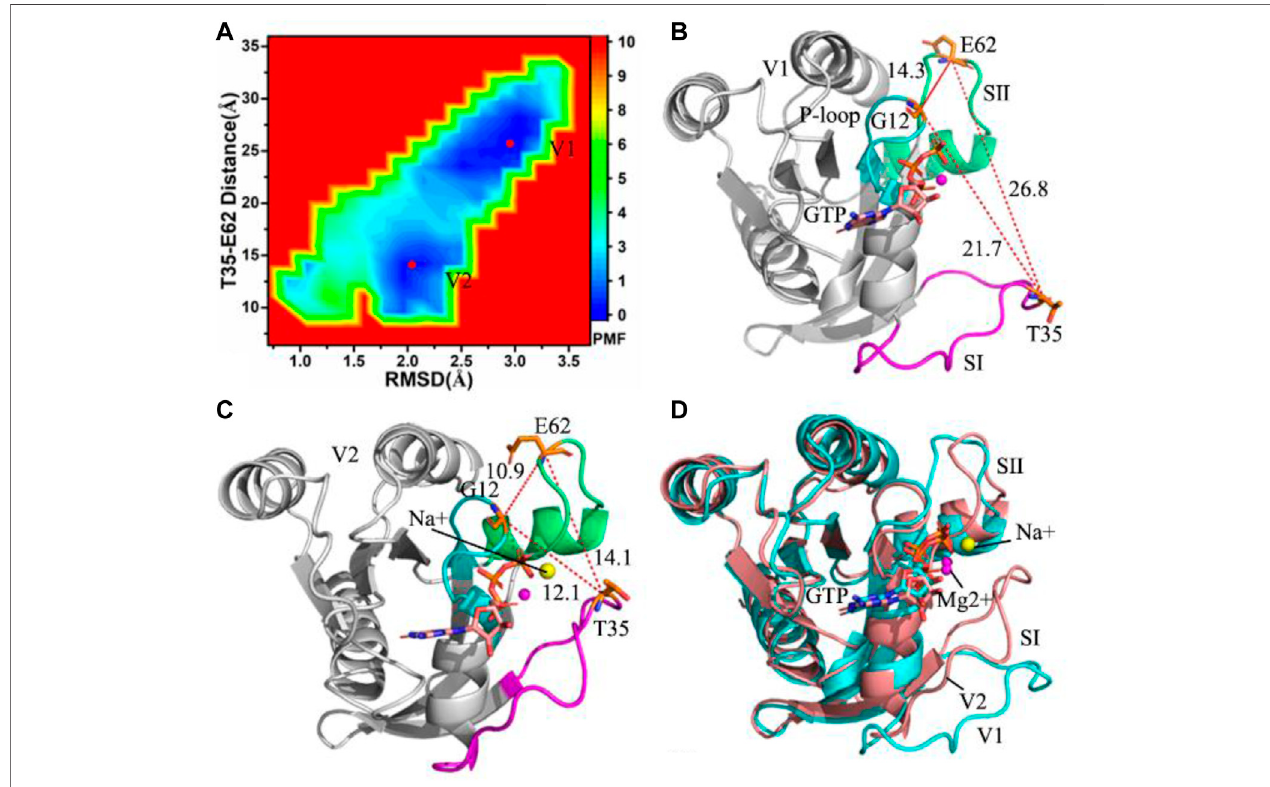
FIGURE1 | Free energylandscapes and representative structuresofthe GTP-bound WT KRAS: (A) free energy landscape constructed withRMSDs ofbackbone atoms and the distance between T35 and E62, (B) representative structure located at energy valley V1, (C) representative structure situated at energy valley V2 and (D) superimposition of two representative